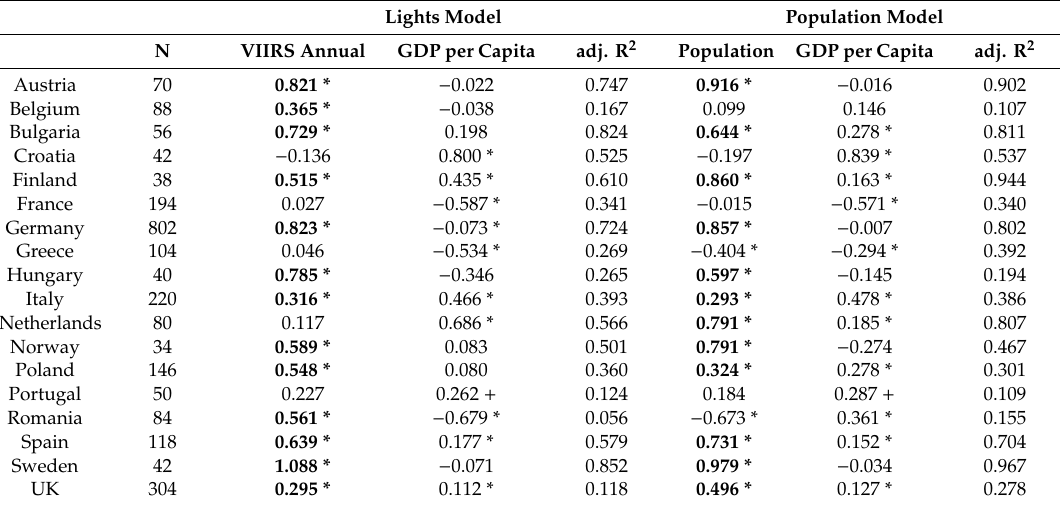
Table 3. Regression results for VIIRS annual lights versus results for